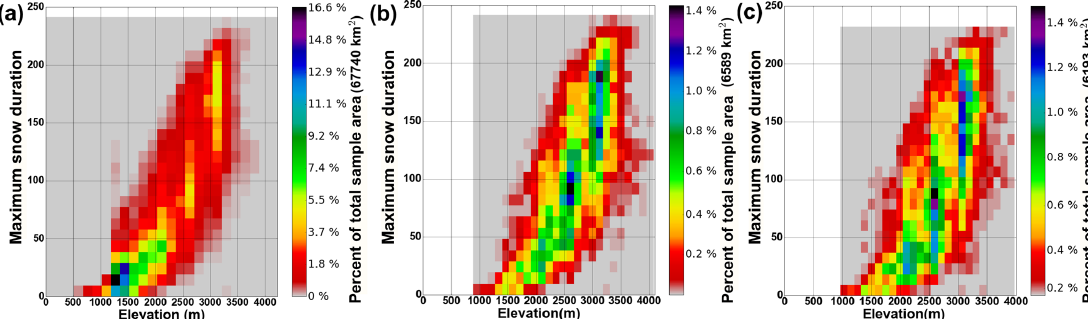
Figure 7. Heat maps of the relationship between elevation and average maximum consecutive snow duration (maximum snow duration) from MODIS at (a) all slopes, (b) north-facing slopes only, and (c) south-facing slopes only in the Great Basin, USA. North facing was defined as northness > 0 . 25 and south facing was defined as northness < − 0 . 25. Color bar scale is different in panel (a) , reflecting the much larger area at low